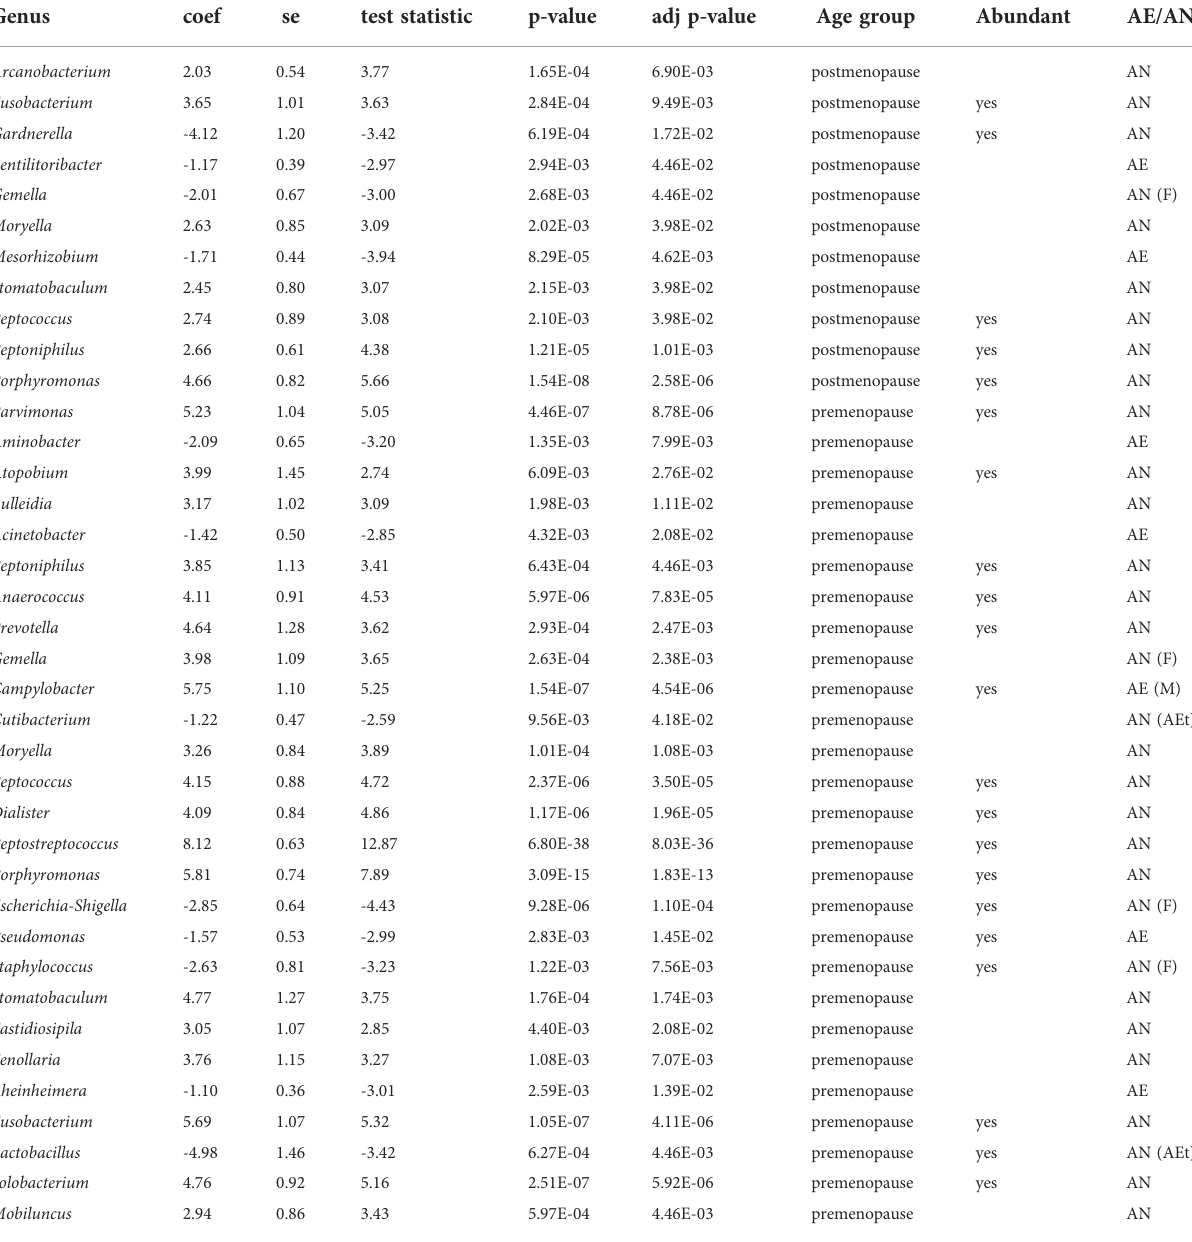
TABLE 2 Bacteria on genus level differentiating healthy controls and pre-treatment samples. Genus coef se test statistic p-value adj p-value Age group Abundant